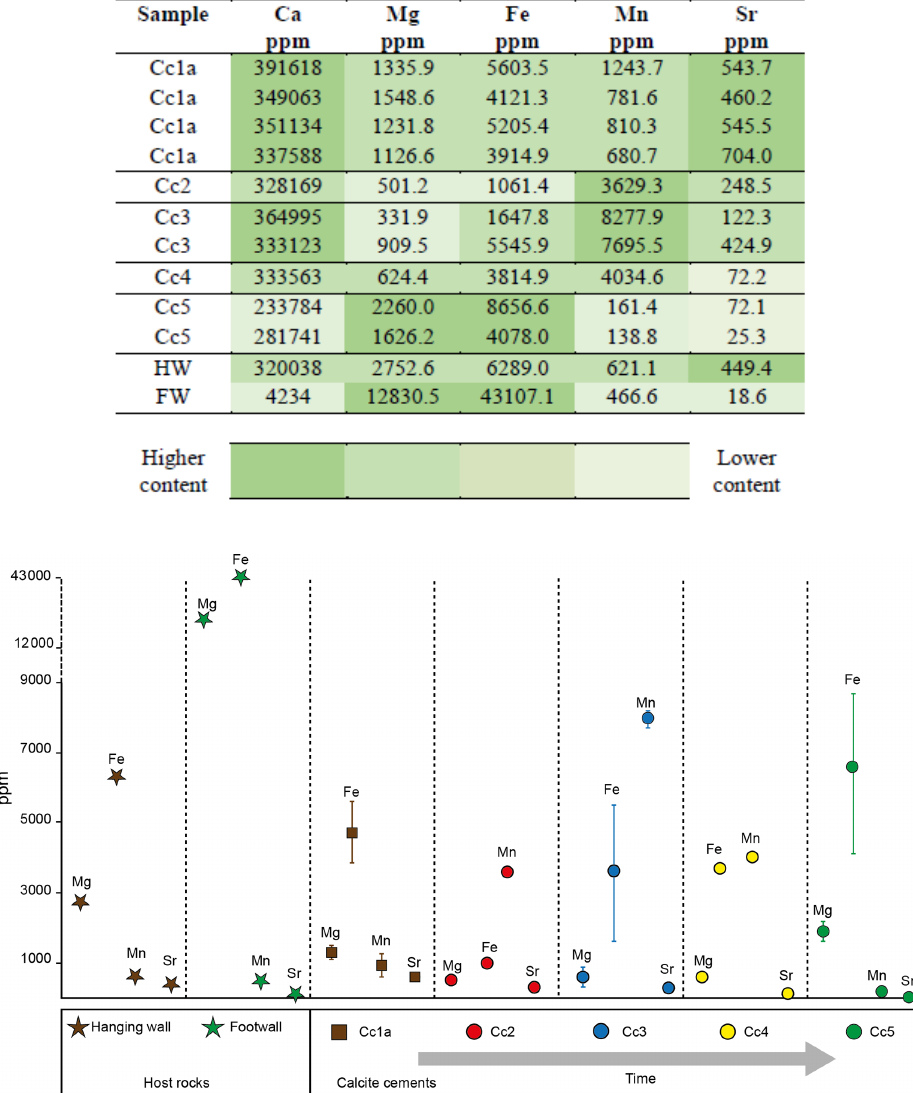
Table 2. Elemental composition (Ca, Mg, Fe, Mn, Sr) of the calcite cements Cc1a to Cc5 and host rocks from the hanging wall (HW) and footwall (FW). The qualitative scale in green indicates different contents (for each element, the darkest green points to the highest concentration and vice versa).